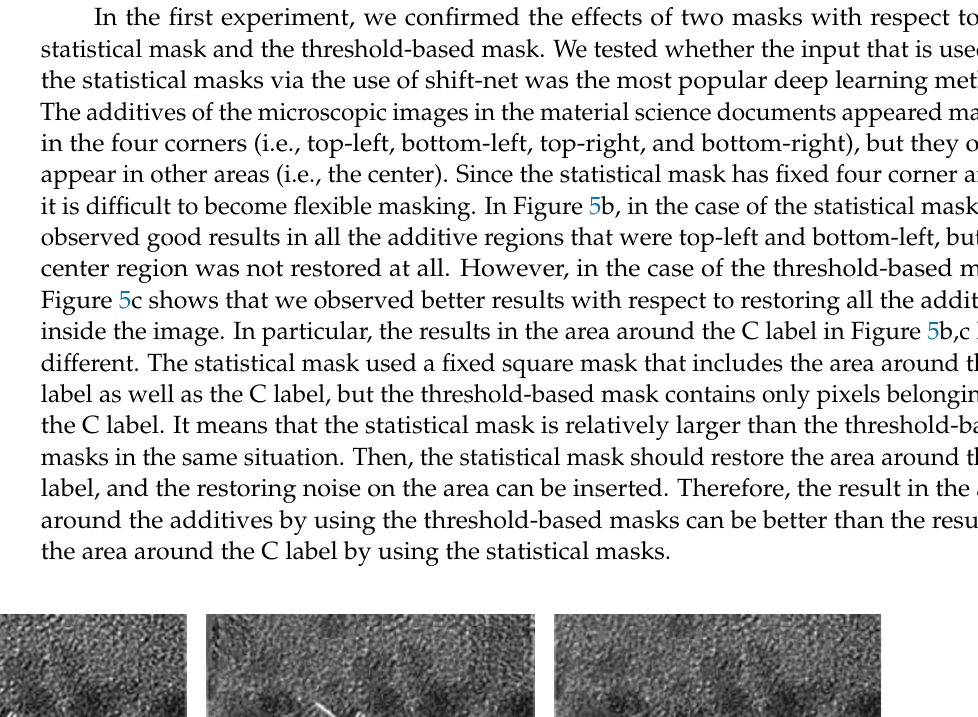
Figure 4. Processing sequence in regard to generating a threshold-based mask from the example of a microscopic image (reprinted with permission from Ref. [40] . Copyright (2021) Elsevier ) . : ( a ) represents the input image; ( b ) represents the intermediate image in the context of threshold-based masking; and ( c ) represents the final image.